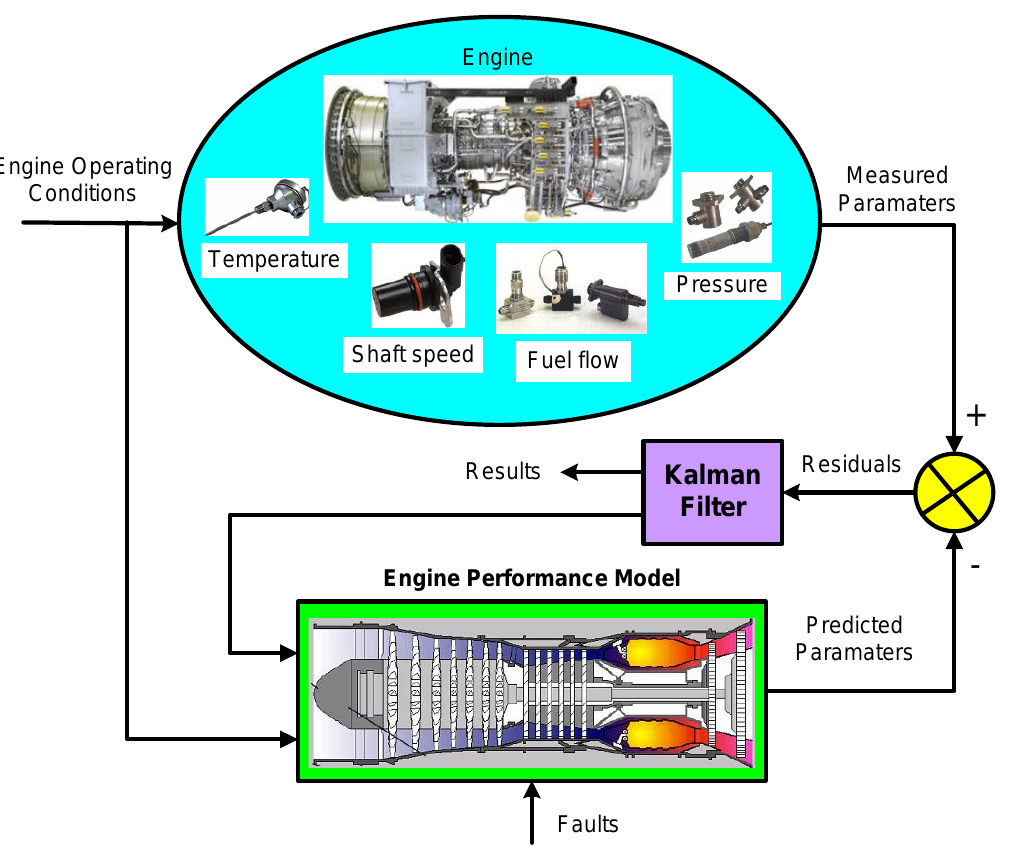
Figure 6. GT gas-path diagnostics using Kalman filter, adapted from [123].